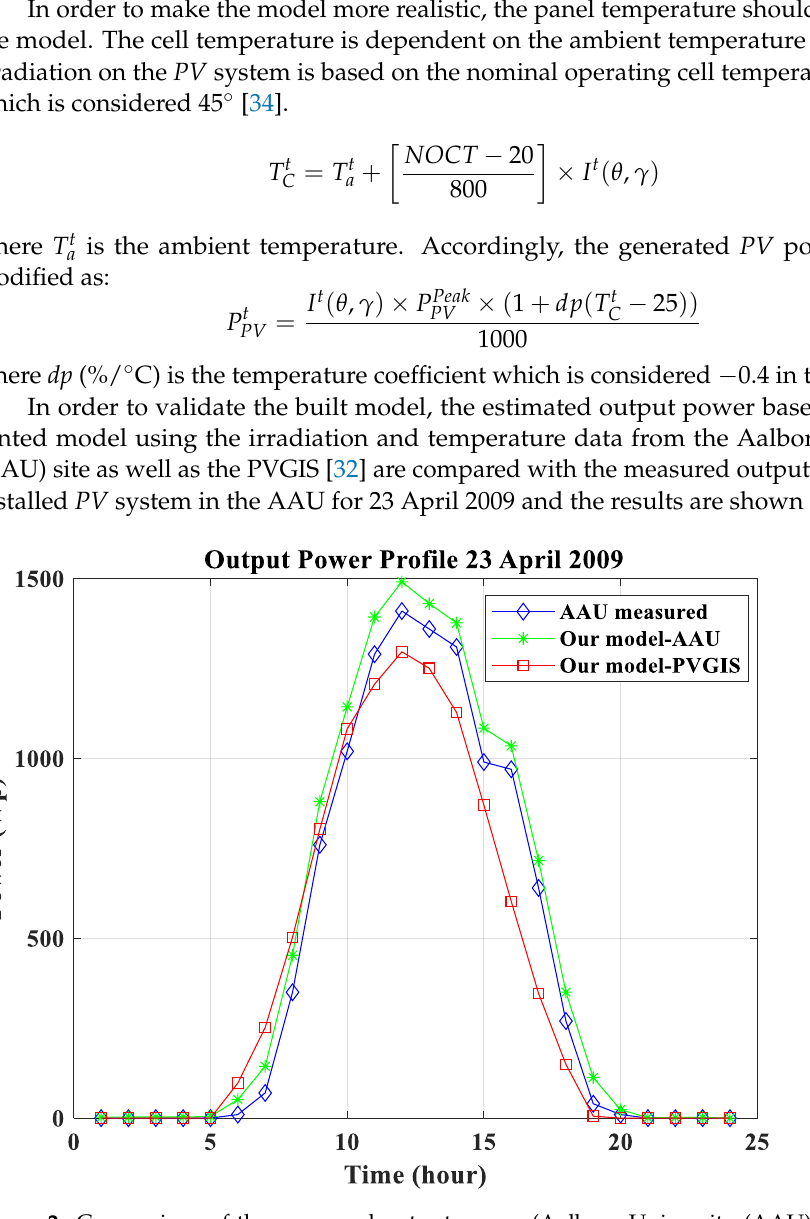
Figure 2. Comparison of the measured output power (Aalborg University (AAU) measured) of the installed photovoltaic (PV) system in the AAU with the estimated output power based on the presented model using the irradiation and temperature data from the AAU site (Our model-AAU) as well as the photovoltaic geographical information system (PVGIS) (Our model-PVGIS).